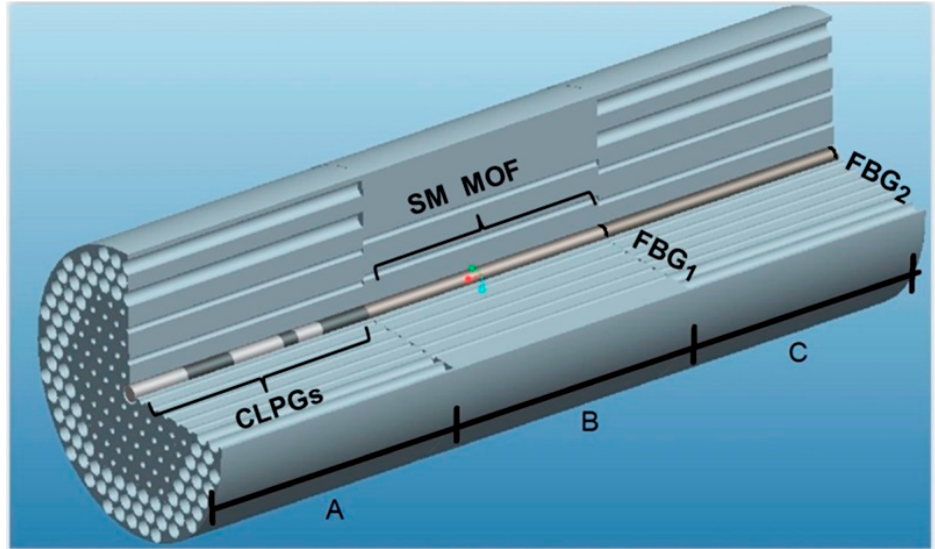
Figure 5. Cross-section of the proposed temperature sensor [68].